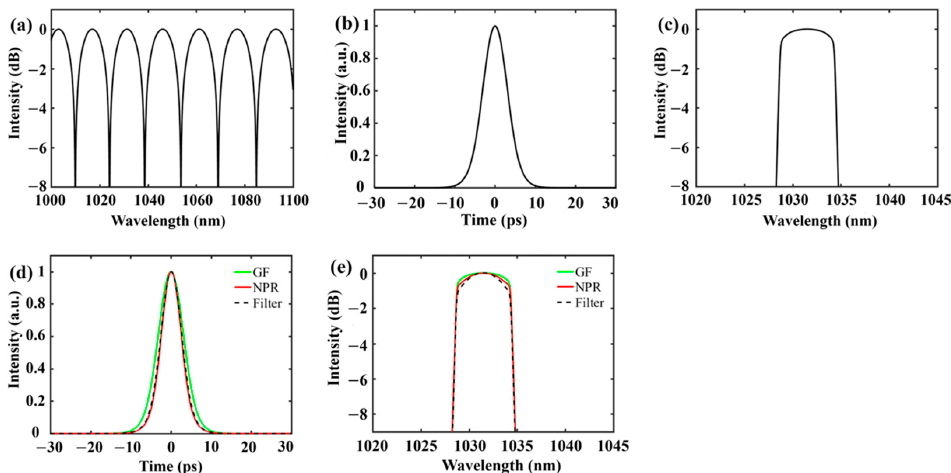
Figure 5. Simulation results with a filter bandwidth of 7.65 nm. ( a ) Transmissivity curve of the filter. ( b ) Pulse shape. ( c ) Output spectrum. ( d ) Pulse shape at different locations of the cavity. ( e ) Spectra at different locations of the cavity.